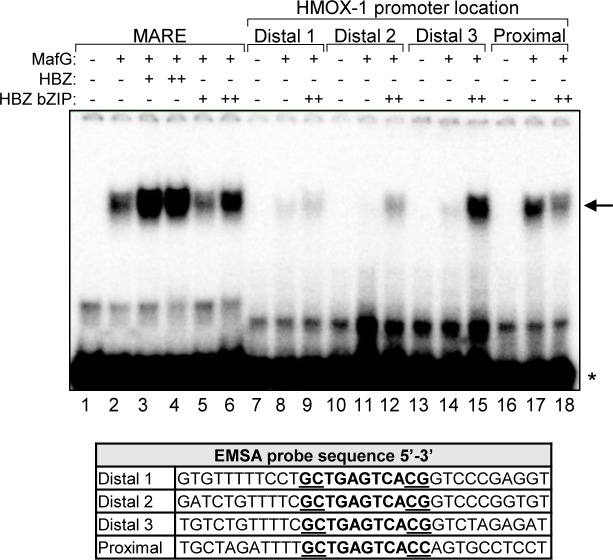
HBZ augments formation of the MafG complex on all three distal MAREs in vitro.In EMSAs, the indicated combinations of recombinant, purified MafG-His (0.5 nM), GST-HBZ (50 or 500 nM), and T7-HBZ-bZIP (50 or 500 nM) were combined with the indicated DNA probes (sequences shown below) prior to electrophoretic separation of complexes. The arrow denotes the shifted protein/DNA complex, the asterisk denotes unbound probe.